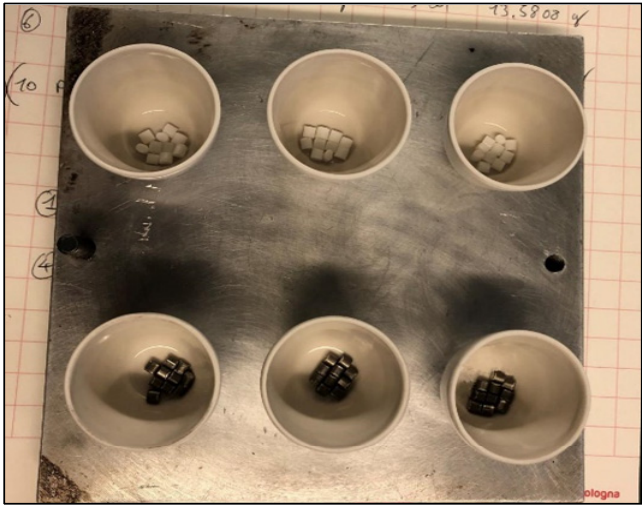
Figure 4. The samples of Arboblend V2 Nature before being inserted in the furnace. Table 2. Weights of the non-coated raw and coated Arboblend V2 Nature pellets. Before Arboblend V2 Nature Raw